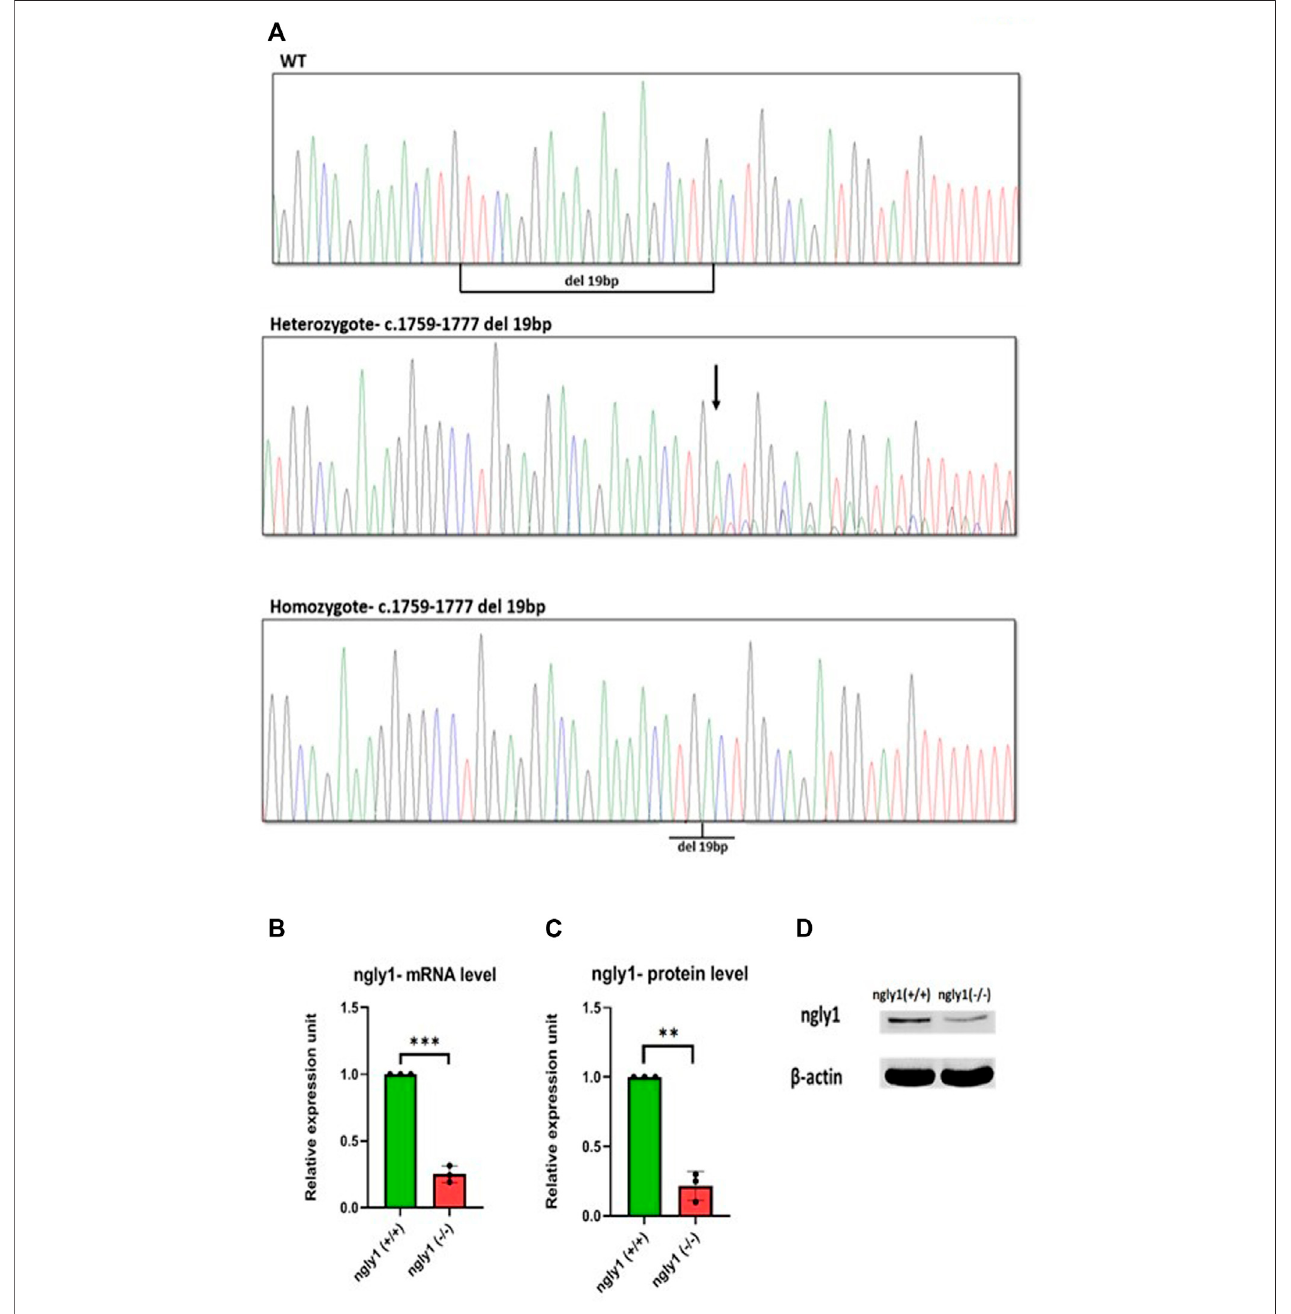
FIGURE 3 | Mutation characterization in zebra fi sh - (A) Genotype screening in DNA extracted from zebra fi sh, Representative electrophoregrams indicating the sequences of WT, heterozygote and homozygote. (B) qPCR analysis quanti fi cation of ngly1 mRNA levels. t-test ( ngly1 ( +/+ ) n = 3, ngly1 ( − / − ) n = 3, *** p < 0.001). (C) WB analysisquanti fi cation ofngly1proteinlevels.t-test( ngly1 ( +/+ ) n =3, ngly1 ( − / − ) n =3,** p < 0.01). (D) WBanalysiswithanantibodyagainst ZFngly1; β -actinwasusedasa loading